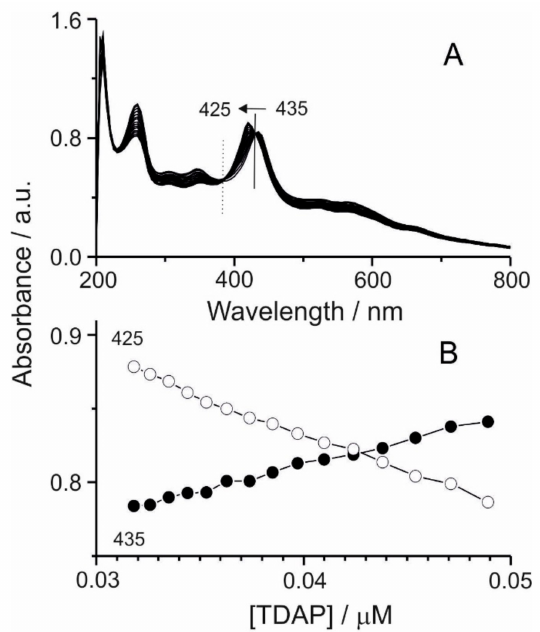
Figure 2. ( A ) Spectral changes obtained upon addition of TCPP to TDAP. Isosbestic points appear at 380 nm (dotted line) and 430 nm (solid line). ( B ) Evolution of absorbance at 425 nm (white dots) and 435 nm (black dots) as the TCPP concentration is